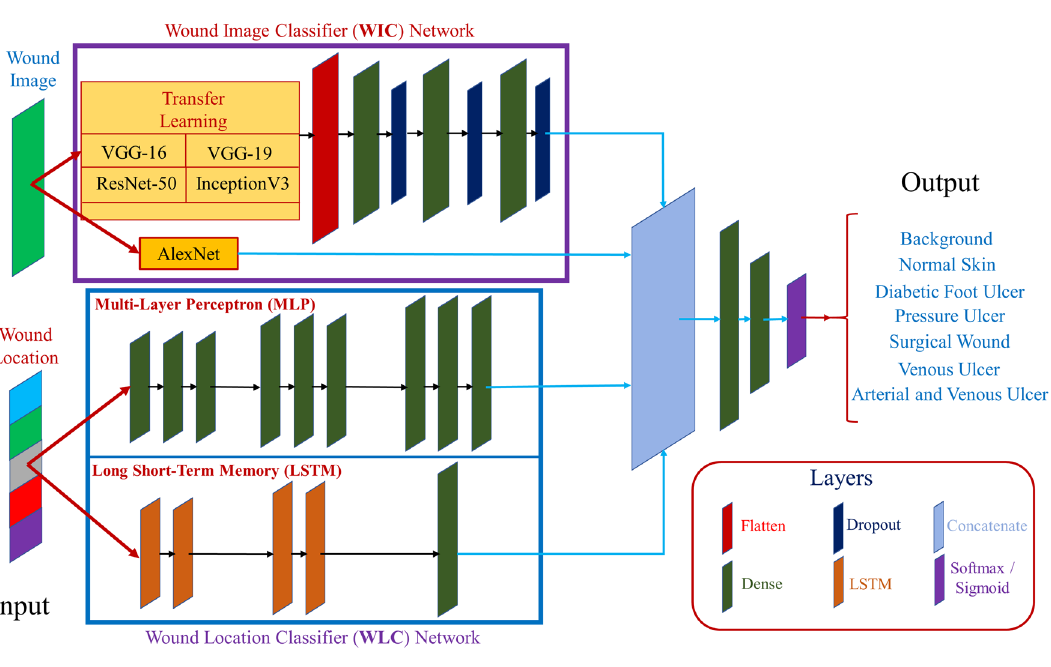
Figure 5. Wound multimodality classifier (WMC) network